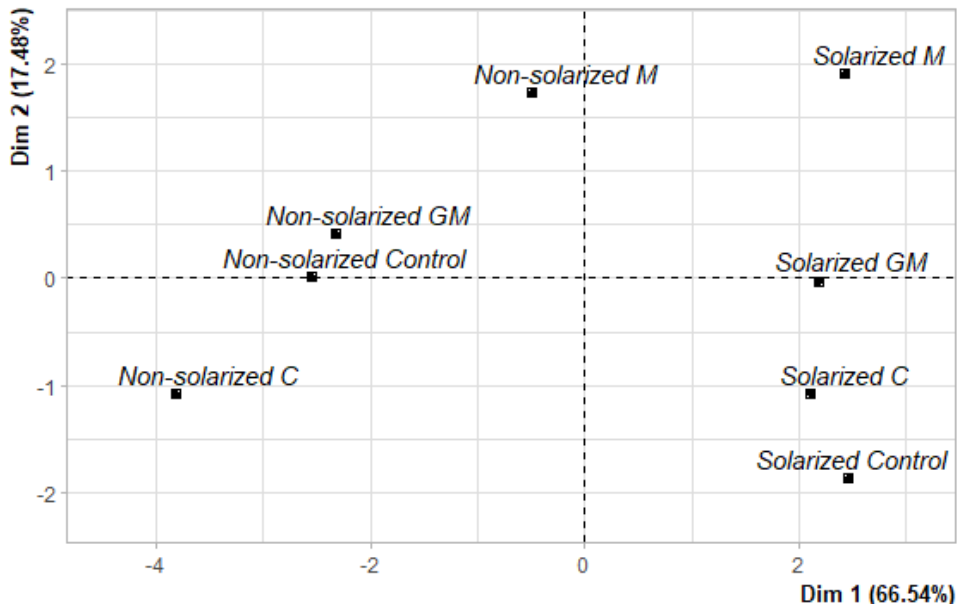
Figure 3. Score plot showing the projection of the treatments in the two-dimensional space. Solarized M Non-solarized M Figure 4. Biplot of loadings and scores in the two-dimensional space.